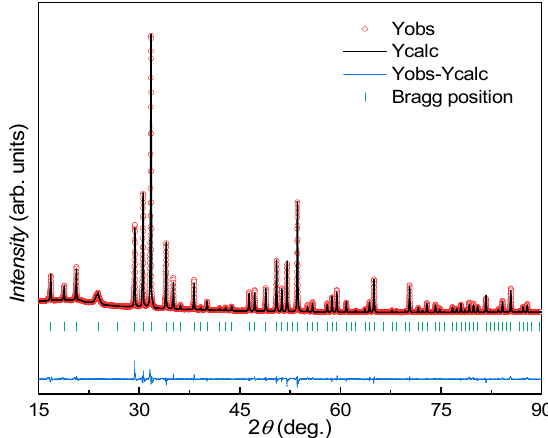
Figure 4. Rietveld refinement of the X-ray powder diffraction (XRD) data for the large crystal L, based on the structure model given in Table 1 (R F = 4,4%, R B = 4.6%).